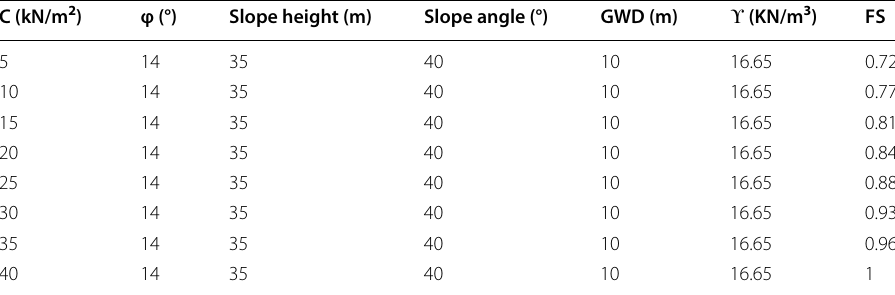
Table 12 Significance of cohesion on the factor of safety of a waste dump